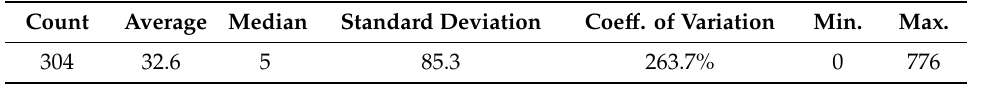
Table 2. Basic descriptive statistics for the number of partnerships during the analyzed promotional events. Count Average Median Standard Deviation Coe ff . of Variation Min. Max. 304 32.6 5 85.3 263.7% 0 776 Source: own